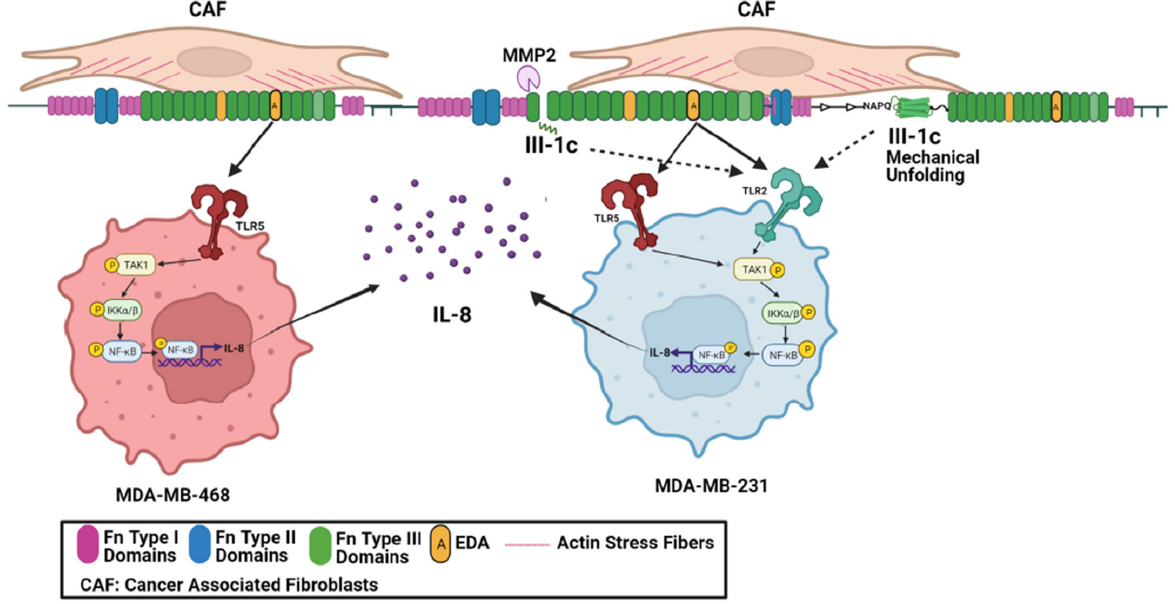
Figure 8. The impact of the tumor microenvironment on TLR activation in TBNC cells. Cancer- associated fibroblasts (CAFs) are highly contractile myofibroblasts which synthesize the EDA isoform of fibronectin and through the generation of mechanical force unfold the III-1 domain allowing the interaction of FnIII-1c with TLR2. In addition, the TNBC cells associate with the Fn matrix using integrin receptors and secrete MMP2 [63,64] which cleaves the fibronectin III-1 domain and frees FnIII-1c to interact with TLR2 on MDA-MB-231 cells. The EDA domain is also available to bind to TLR5 on MDA-MB-468 cells and to both TLR2 and TLR5 on MDA-MB-231 cells. Activation of the TLRs then leads to downstream signaling to activate TAK1 and IKK α / β and subsequent activation of NF κ B. NF κ B translocates to the nucleus where it acts as a transcription factor to regulate expression of IL-8. This graph was created using BioRender.